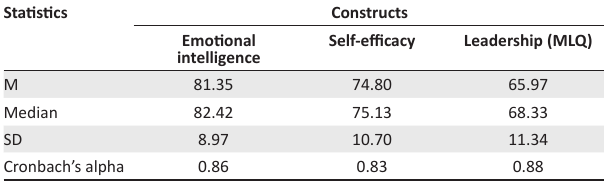
TABLE 2: Summary of descriptive statistics for each construct.